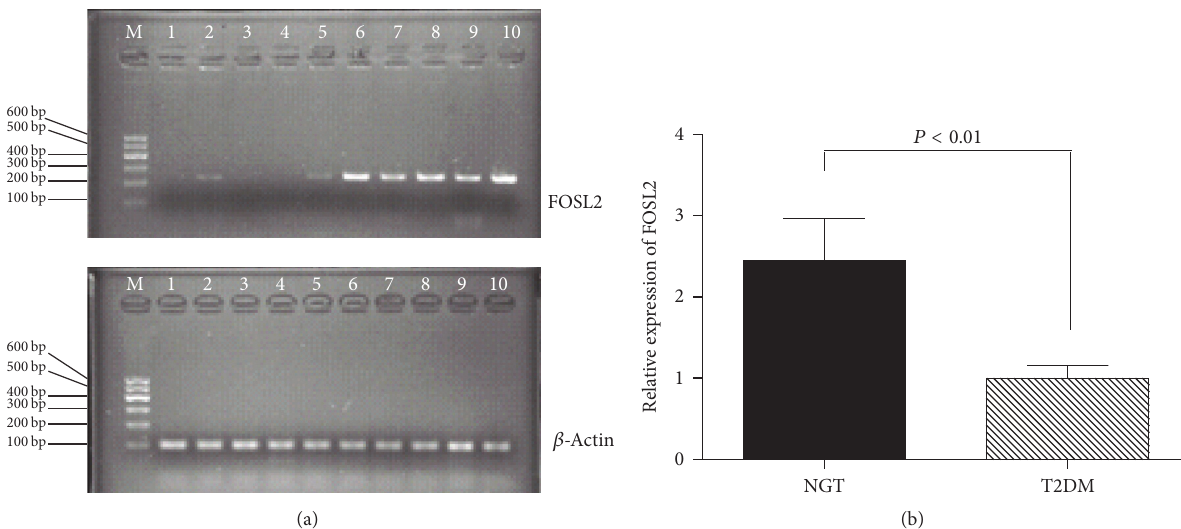
Figure 1: The comparison of the expression of FOSL2 mRNA between the NGT and T2DM groups in Uyghurs in Xinjiang. (a) Electrophoretogram of FOSL2 mRNA. M: molecular weight marker; 𝛽 -actin was the internal reference gene. 1–5 and 6–10 in (a) were the FOSL2 of T2DM and NGT groups, respectively, in Uyghurs in Xinjiang. (b) The mRNA relative quantification expression of FOSL2 in the two groups.